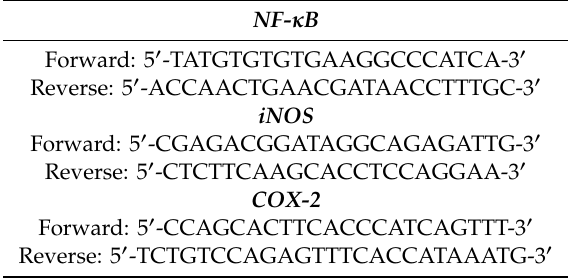
Table 1. Primers used for quantitative reverse transcription polymerase chain reaction for the analysis of inflammatory gene